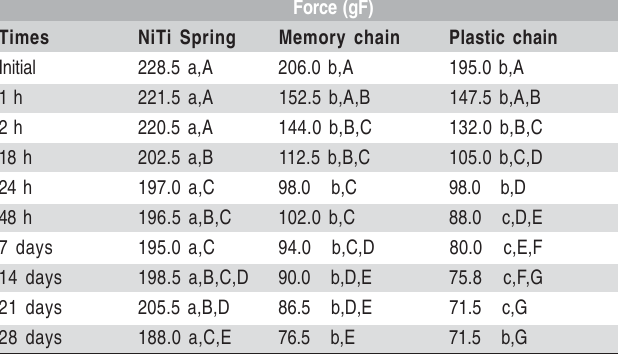
Table 1 - Median (1st and 3rd quartiles) of force (in gF) as